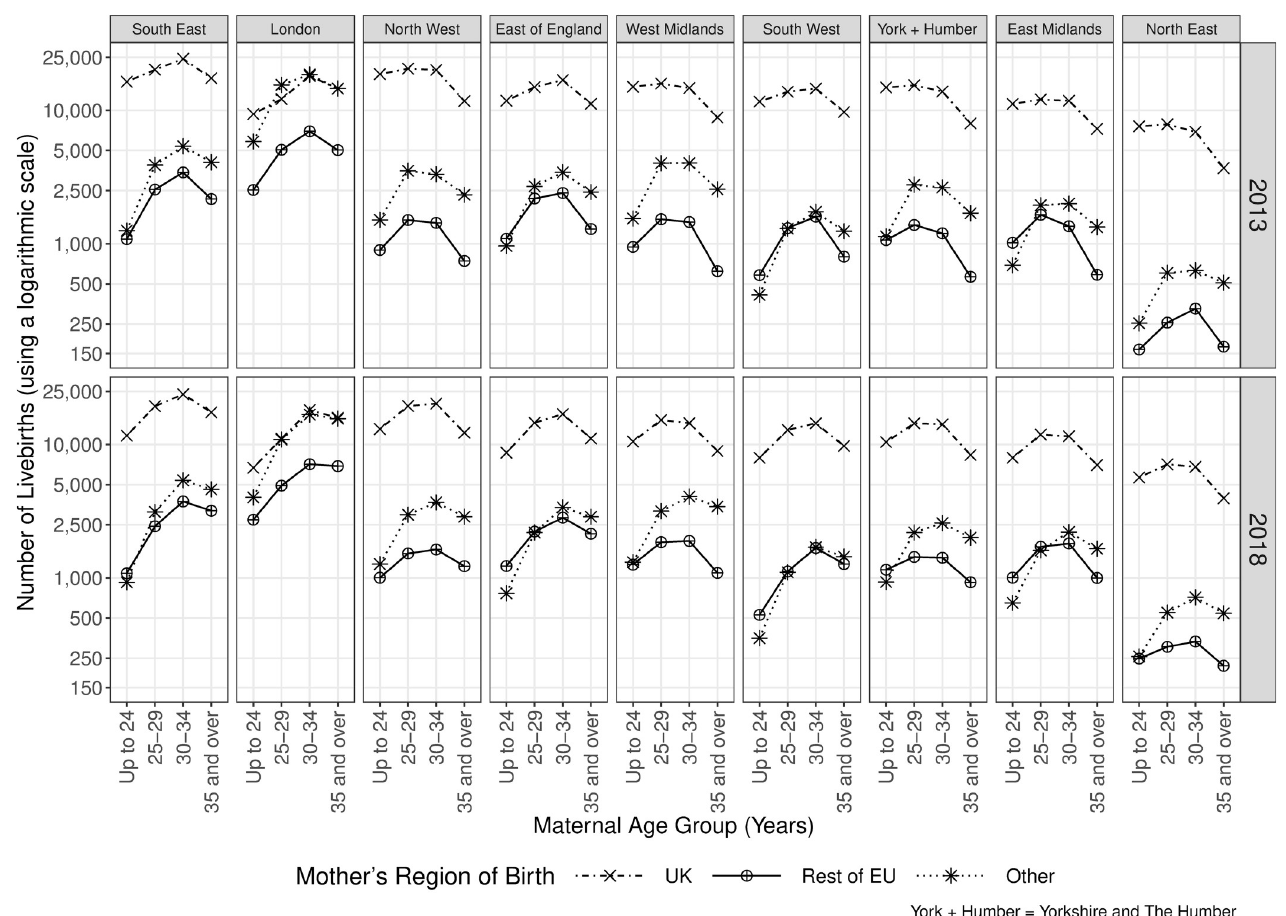
Fig 1. Number of livebirths in each of the nine regions of England in the years 2013 and 2018 by maternal age group and RoB. A logarithmic scale has been used for the number of livebirths.